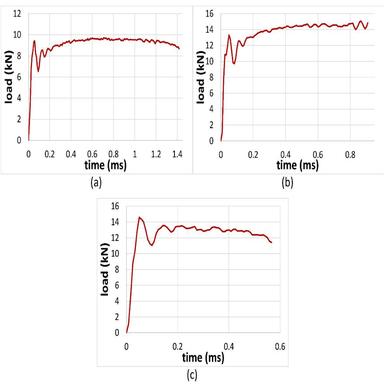
Measured load data (a) DP590 (b) DP780 (c) DP980.